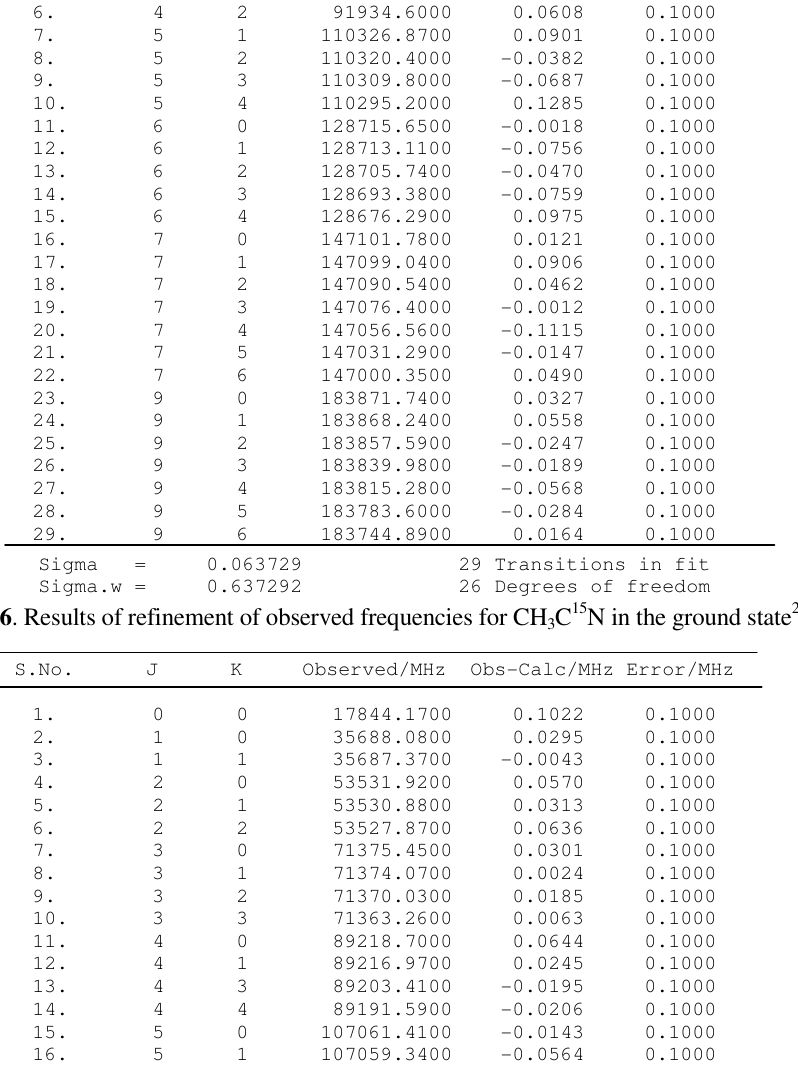
Table 5 . Results of refinement of observed frequencies for CH 313 CN in the ground state 22 . S.No.